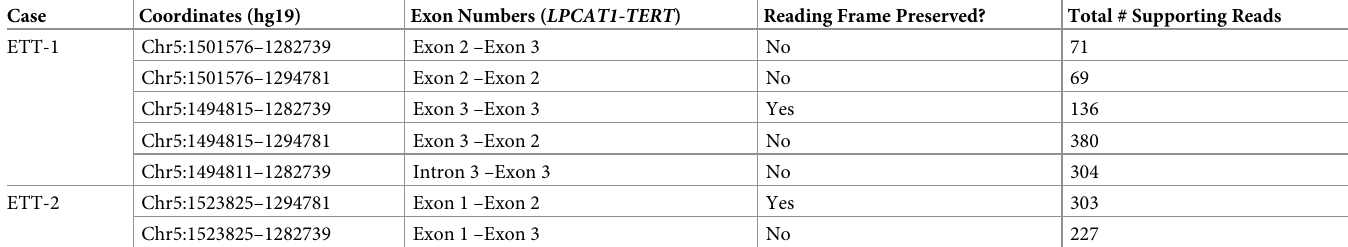
Table 2. Junction exon combinations, genomic coordinates, reading frame status and supporting read counts for LPCAT1-TERT fusions identified in two epitheli- oid trophoblastic tumors by RNA-Seq. Case Coordinates